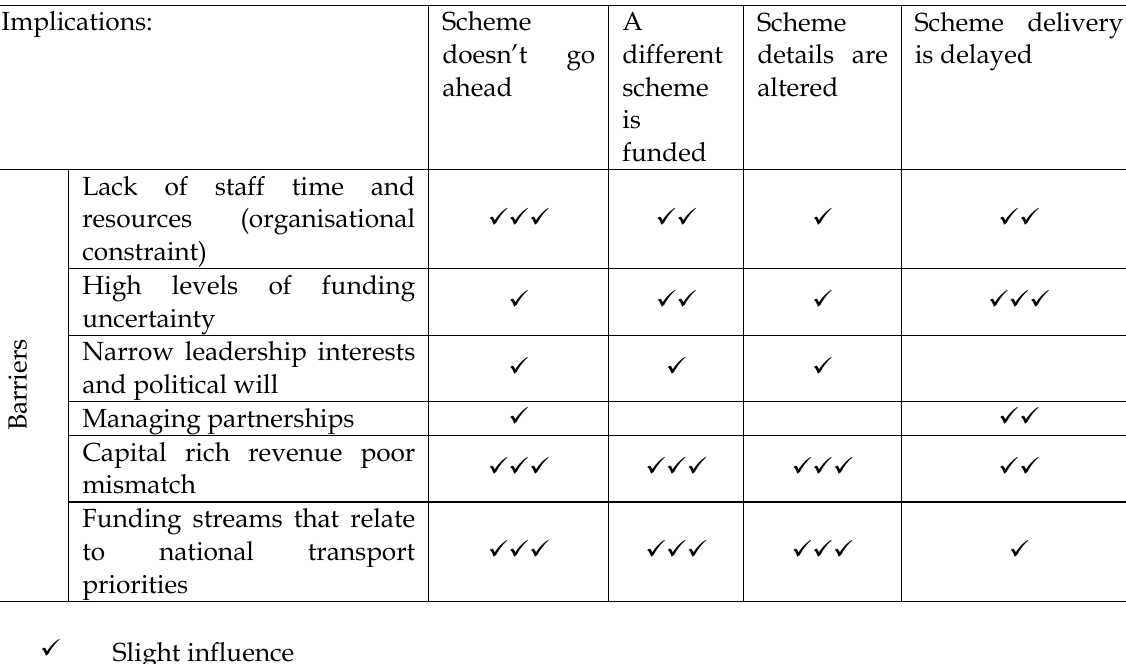
Figure 1. Funding barriers and their